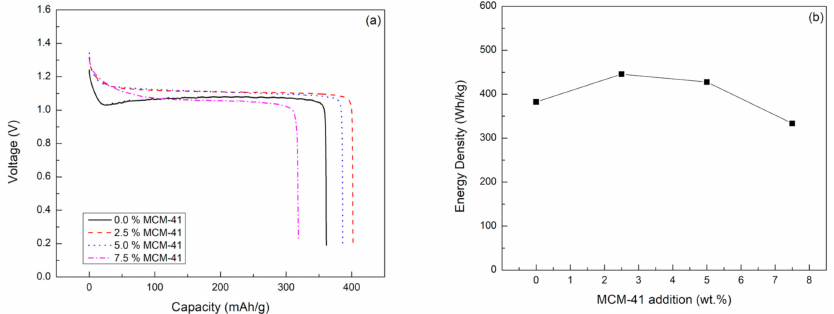
Figure 3. ( a ) Discharge capacity and ( b ) energy density of ZABs using a composite MCM-41 / PVA membrane having di ff erent amounts of MCM-41 loading at constant discharge current of 5